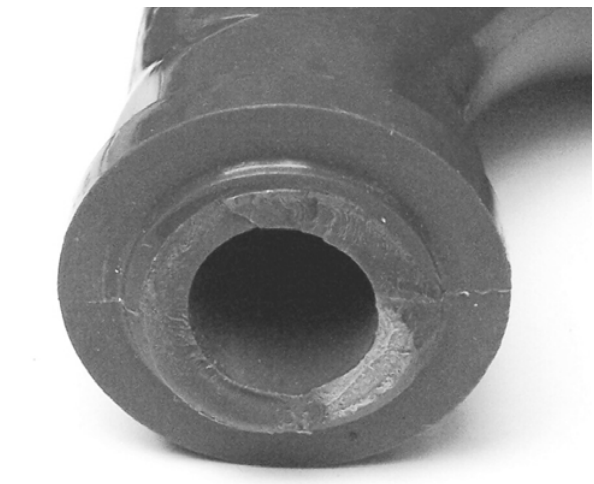
Figure 8. Crack surface of plastic domestic tap.